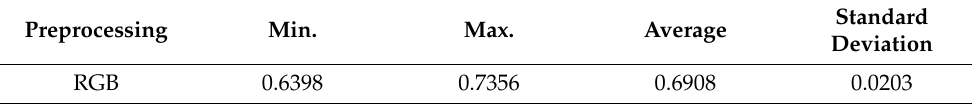
Table 8. Results of the